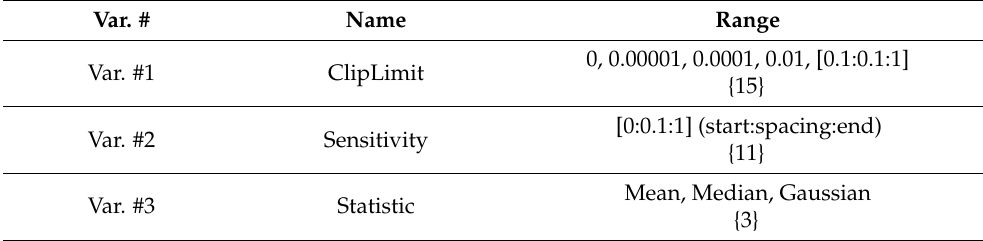
Table 3. Analysis